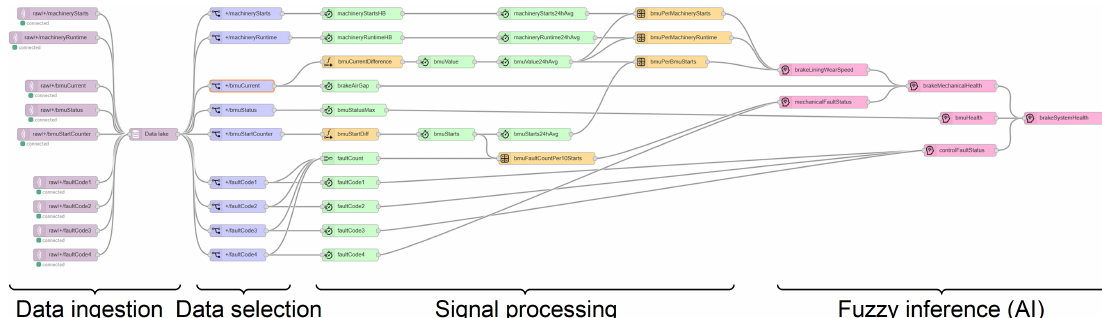
Figure 9. A screenshot sample of the development environment showing the flow nodes of the artificial intelligence (AI)-enhanced brake condition monitoring application. The node categories at the bottom were added afterward. Purple nodes represent data ingestion, blue are data selection, green and yellow ones perform signal processing, and red nodes implement fuzzy inference.